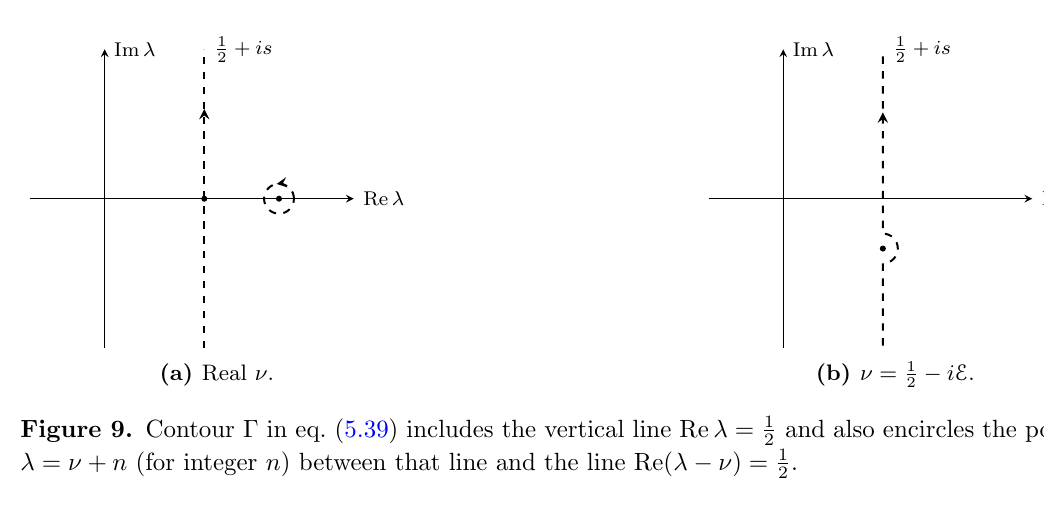
and the symmetry (cid:5) (cid:23) = (cid:5) (cid:23) , which allows one to extend the integral in (5.35) from a (cid:21) 1 (cid:0) (cid:21) half-line to a full line. More